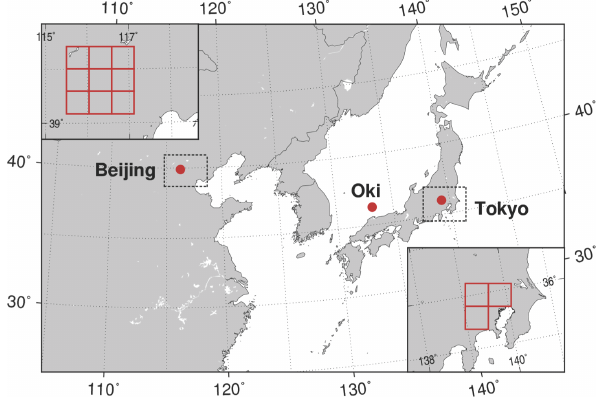
Figure 1. Grids for comparison of the model simulation and ob- servation; Beijing and Tokyo metropolitan areas and Oki EANET